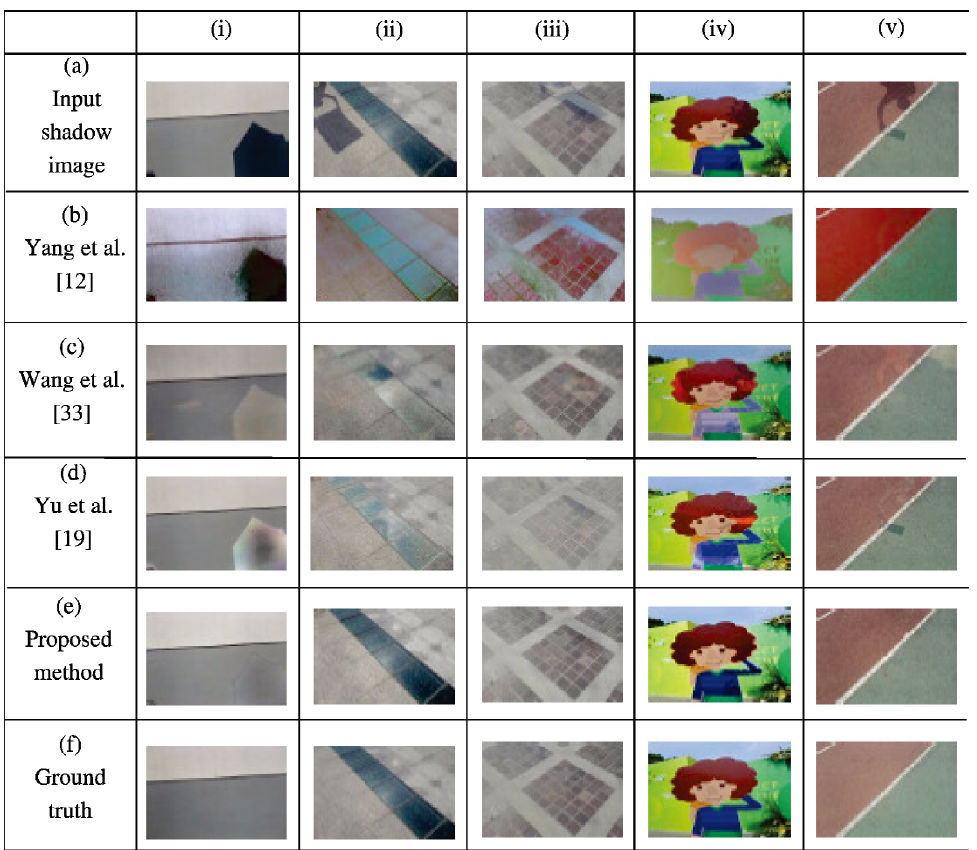
Fig. 5 Comparison of shadow removal techniques using images from the ISTD dataset. Row (a) has the original shadow images. Row (f) has the corresponding shadow-free ground truths. Rows (b–e) contain results using the approach named in the first